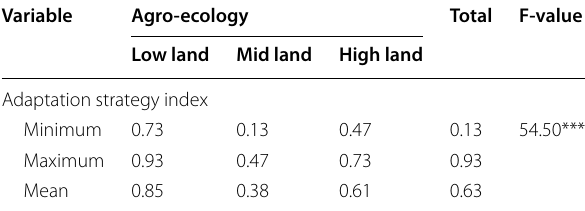
Table 4 Adaptation strategy index by agro-ecology